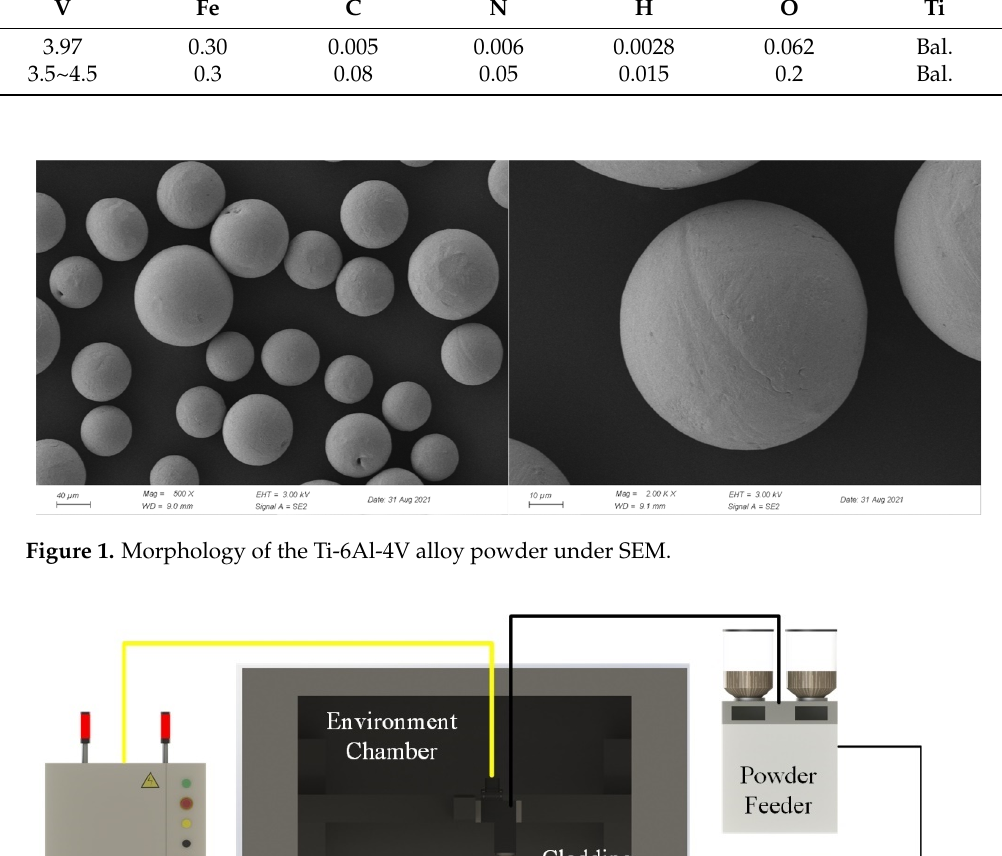
Table 1. Chemical composition of Ti-6Al-4V alloy powder and plate (wt.%).